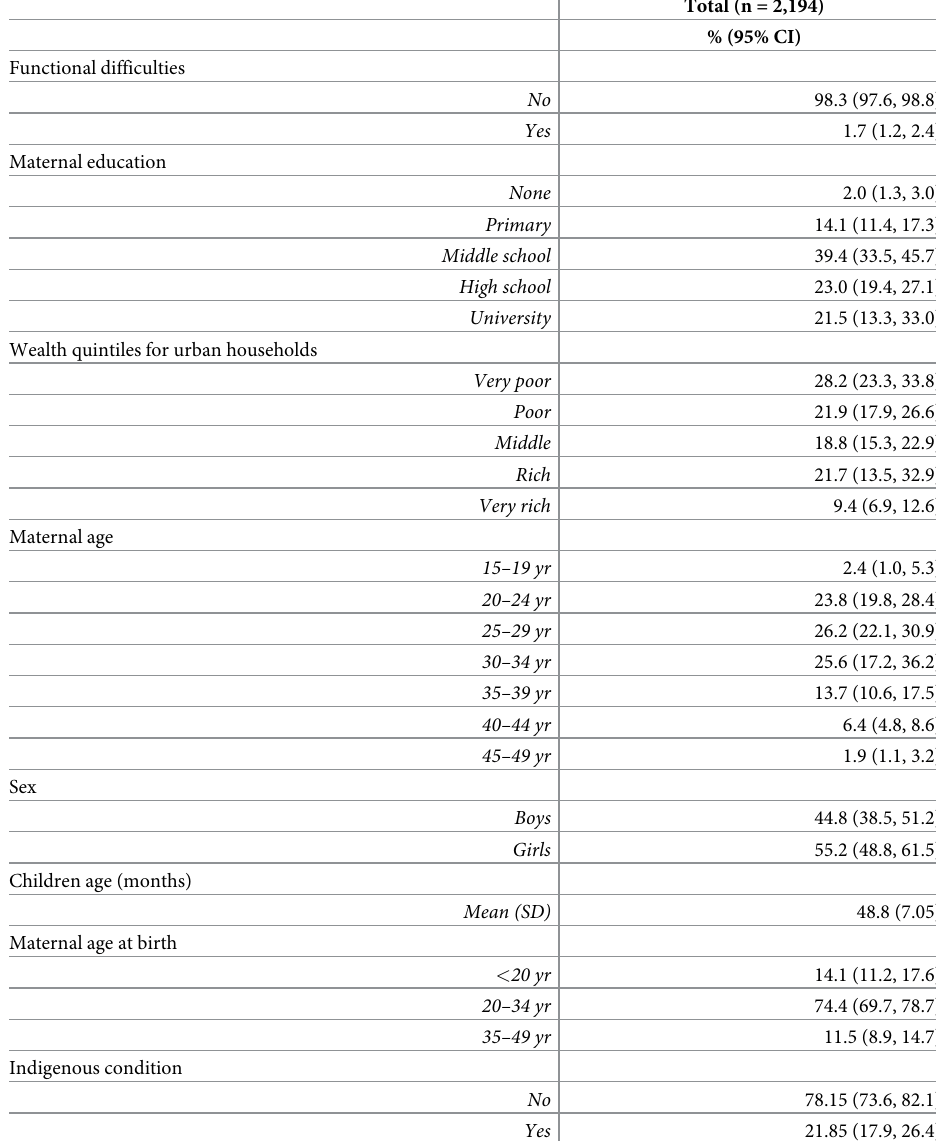
Table 1. Individual characteristics for the children in the